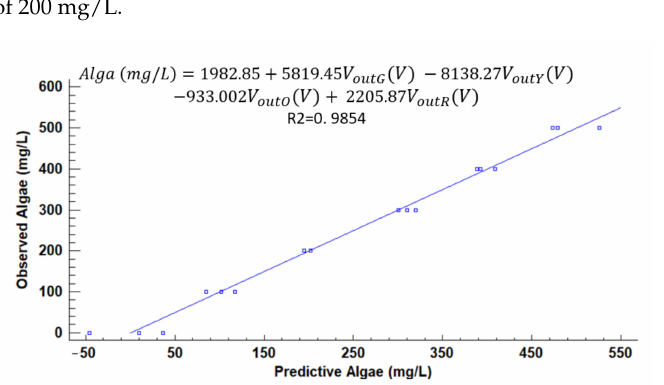
Figure 15. Observed vs. predicted values of algae concentration with a solid concentration of 500 mg/L.